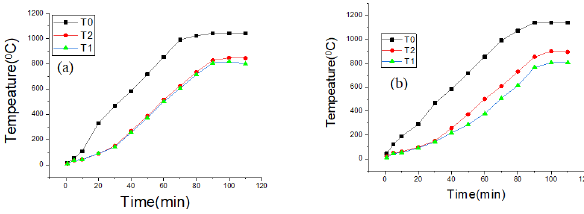
Figure 13: Diagram of temperature as a function for coated samples